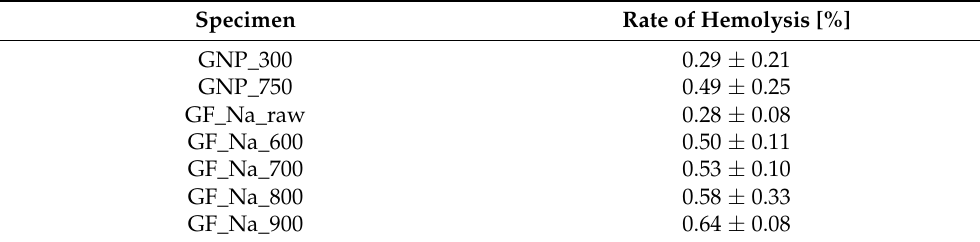
Table 5. The hemolysis rate [%] for different types of graphene samples.